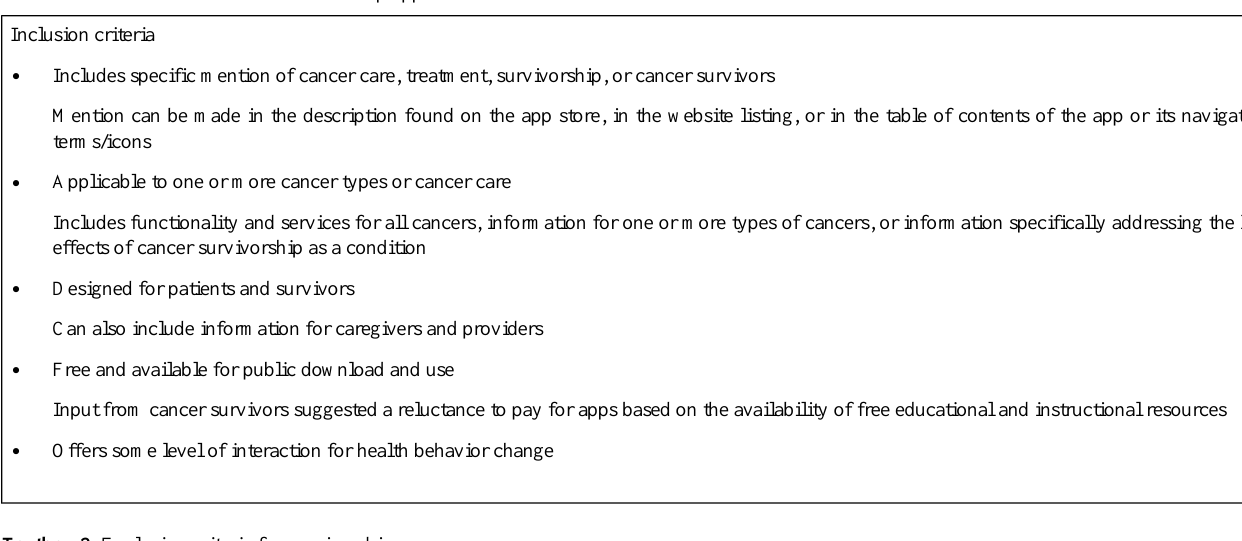
Textbox 1. Inclusion criteria for survivorship